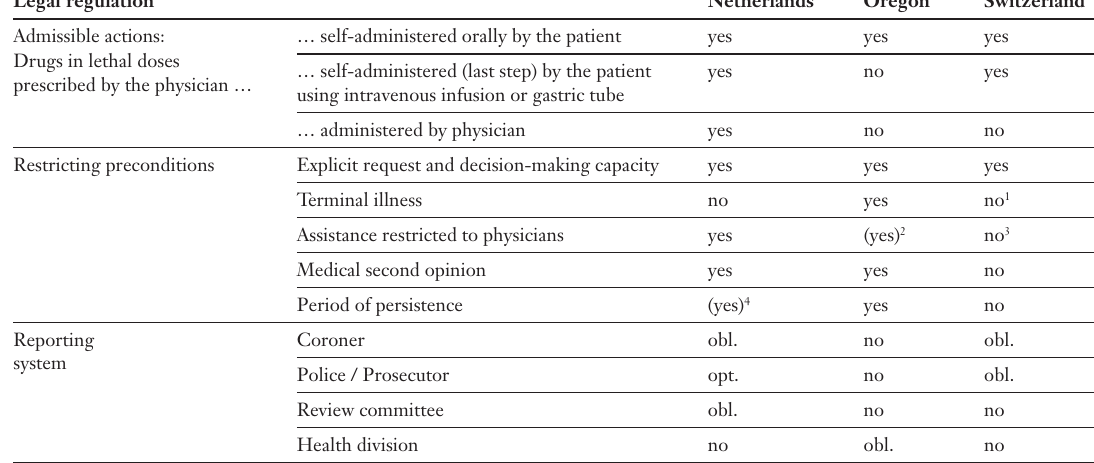
Overview of the leg- islation governing assisted dying in The Netherlands, Oregon and Switzerland (obl. = obligatory, opt. =